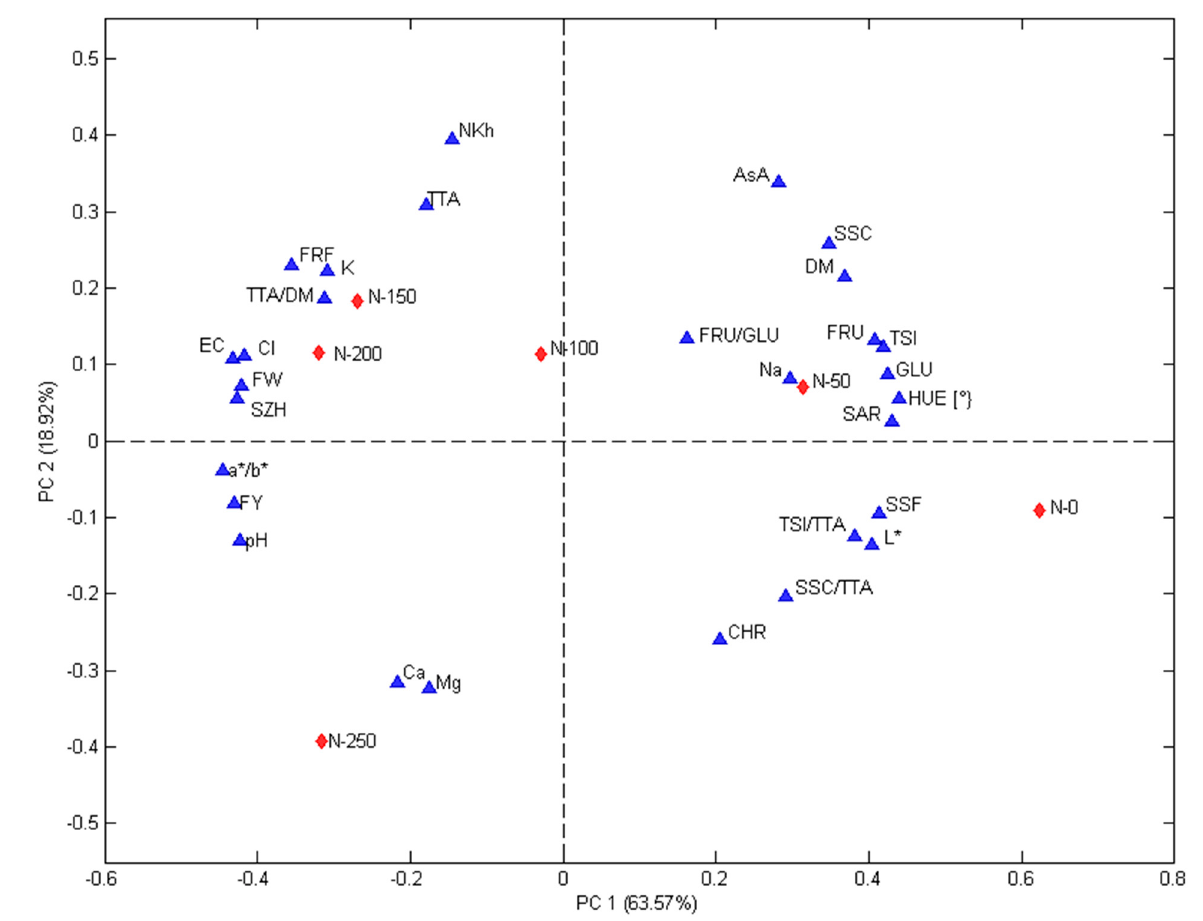
Figure 3. Biplot of Principal Component Analysis results. The assessed treatments (red diamonds) on cv “Messapico” plants are N-0 = 0 kg N ha − 1 ; N-50 = 50 kg N ha − 1 ; N-100 = 100 kg N ha − 1 ; N-150 = 150 kg N ha − 1 ; N-200 = 200 kg N ha − 1 ; N-250 = 250 kg N ha − 1 . The studied parameters (blue triangles) are: FY = marketable yield per plant ; FRW = average fruit weight; NF = fruit number per plant; SSF = sunscald fruits; SZH = size homogeneity; FRF = fruit firmness; DM = dry matter; SSC = soluble solids content; TTA = titratable acidity; pH; L*= lightness; a*/b* ratio; HUE = hue angle; CHR = chroma; CI = color index; EC = electrical conductivity; GLU = glucose; FRU = fructose; FRU/GLU = fructose to glucose ratio; TSI = total sweetness index; TSI/TTA = total sweetness index to total titratable acidity ratio; SSC/TTA= soluble solids content to total titratable acidity ratio; TTA/DM = total titratable acidity to dry matter ratio; AsA = ascorbic acid; Mg = magnesium; Ca = calcium; K = potassium; Na = sodium content; N Kh = nitrogen.